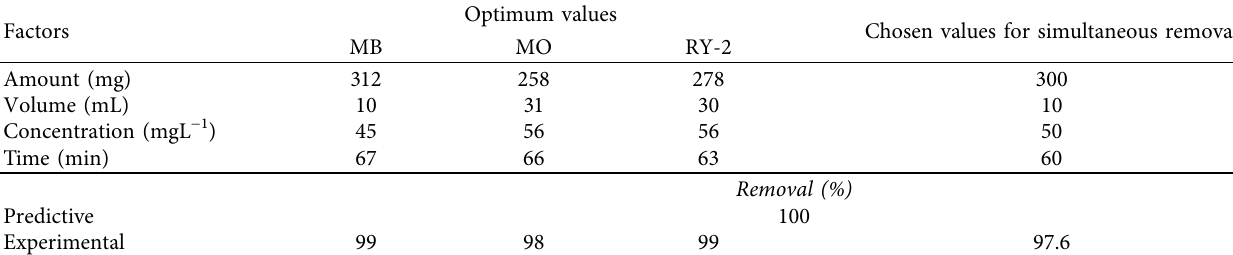
Table 3: Optimum conditions for simultaneous removal and application to real wastewater